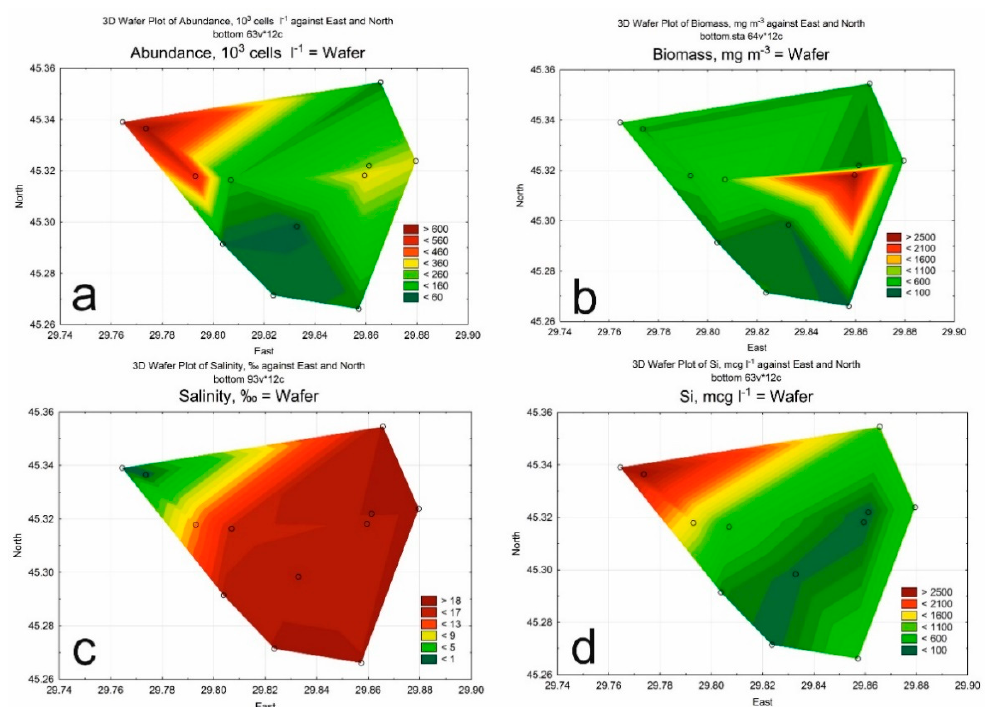
Figure 3. Statistically generated maps of nutrients from the surface horizon in the Ukrainian part of the Danube nearshore area in August 2018: nitrates (NO 3– ) ( a ); dissolved organic nitrogene (DON) ( b ); dissolved inorganic phosphorus (DIP = РО 43– ) ( c ); dissolved organic phosphorus (DOP) ( d ).